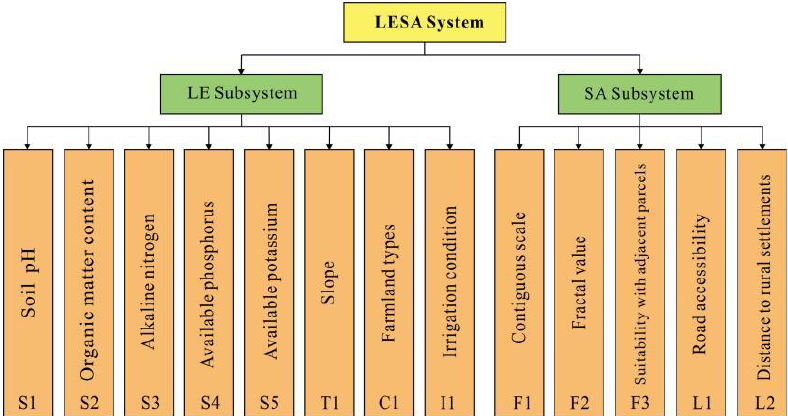
Figure 3. LESA system framework.